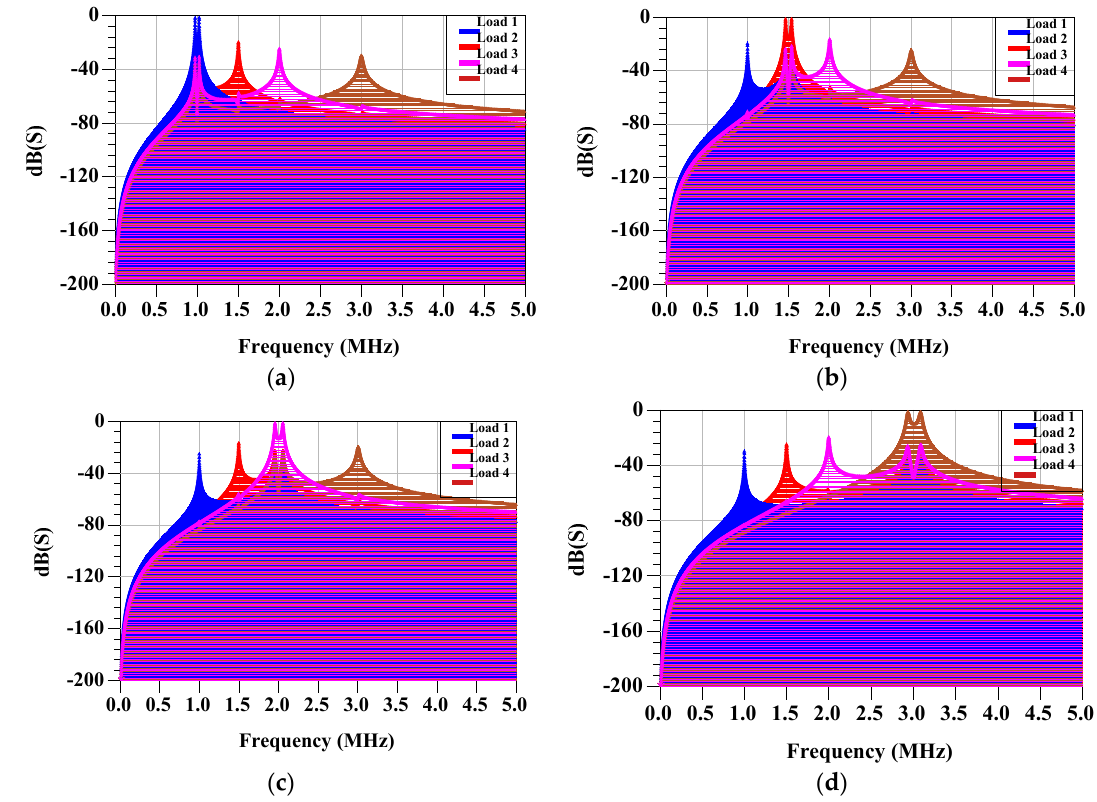
Figure 5. S Parameter dB of the system without compensation ( a ) dB(S) when Rx1-on; ( b ) dB(S) when Rx2-on; ( c ) dB(S) when Rx3-on; ( d ) dB(S) when Rx4-on. Table 1. Circuit design parameters.